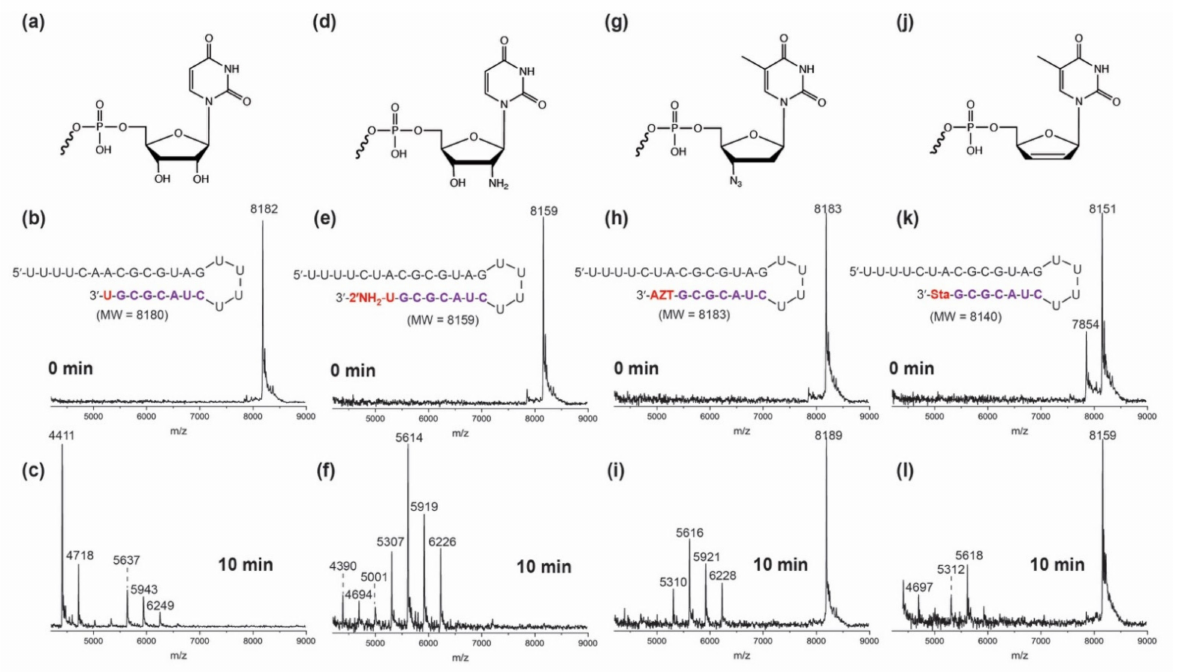
Figure 3. SARS-CoV-2 exonuclease activity with uridine- or uridine-analogue terminated RNA. A mixture of 500 nM template-loop-primer terminated at its 3 (cid:48) end with either U ( a ), 2 (cid:48) -NH 2 -U ( d ), Zidovudine (AZT) ( g ) or Stavudine (Sta) ( j ) (sequences shown in b , e , h , k ) and SARS-CoV-2 pre-assembled exonuclease complex (Nsp14/Nsp10) was incubated at 37 ◦ C for 10 min. These intact RNAs ( b , e , h , k ) and their respective exonuclease reaction products ( c , f , i , l ) were analyzed by MALDI-TOF MS. The signal intensity was normalized to the highest